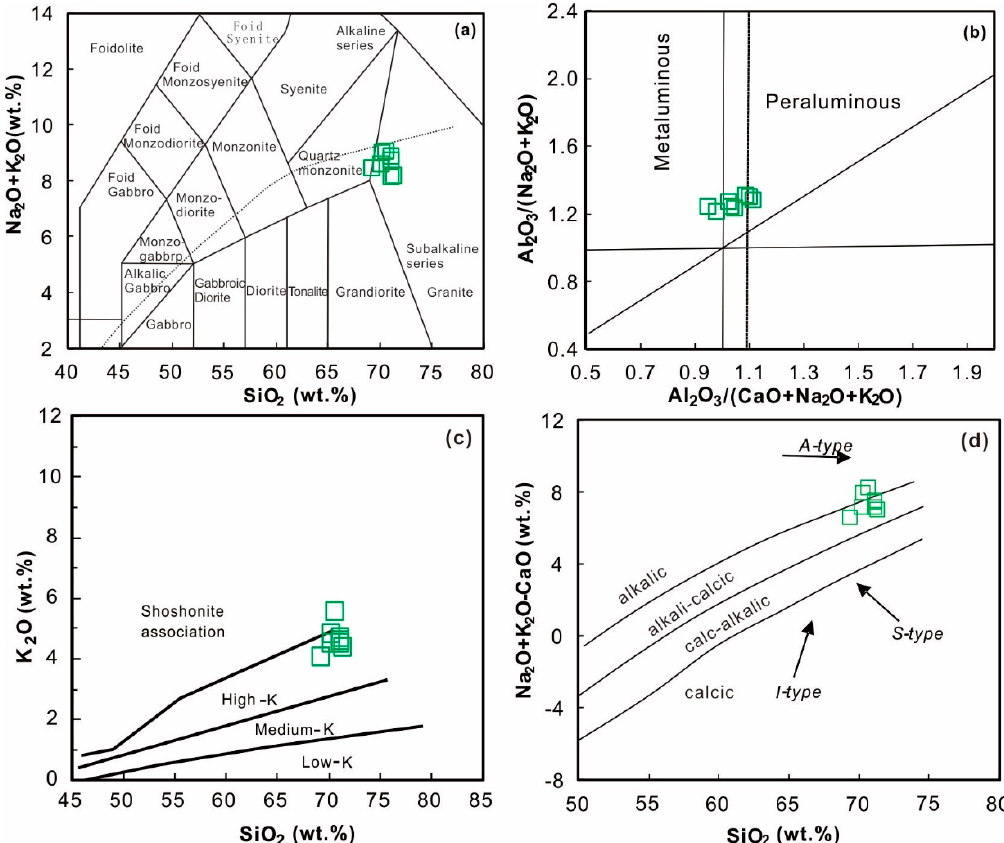
Figure 3. Geochemical classification of granitoids from the Banzhusi granite porphyry. ( a ) Total alkali-silica diagram [67], where the dashed line separating the alkaline series from the subalkaline series is from [68]. ( b ) Al 2 O 3 /(Na 2 O + K 2 O) versus Al 2 O 3 /(CaO + Na 2 O + K 2 O) plot [69]. ( c ) K 2 O versus SiO 2 diagram (modified from [70,71]). ( d ) SiO 2 versus Na 2 O + K 2 O − CaO [72].